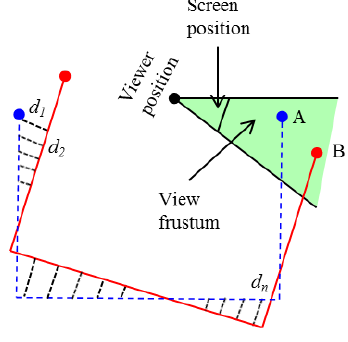
Figure 5: User moves surface B towards surface A while im- mersed in the point